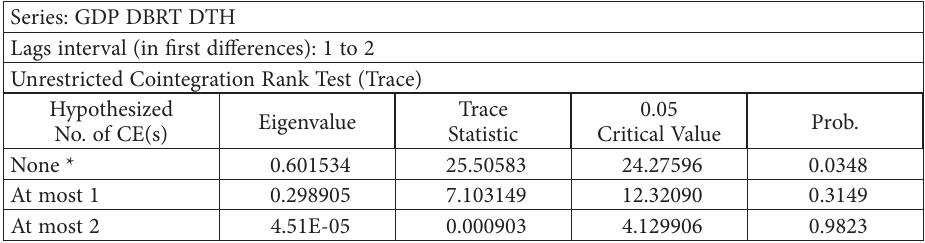
Table 11. Johansen Cointegration Test for Cluster B Series: GDP DBRT DTH Lags interval (in first differences): 1 to